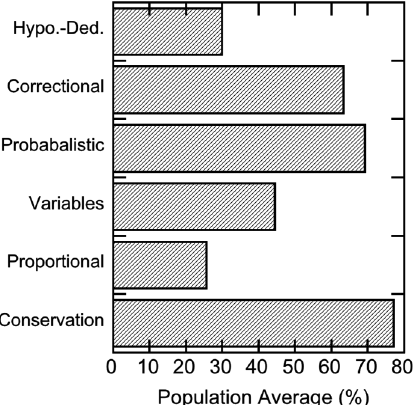
FIG. 2. Population averages on specific scientific reasoning patterns as assessed by the LCTSR. Significant difficulty is observed with proportional reasoning, isolation of variables, and hypothetico-deductive reasoning.